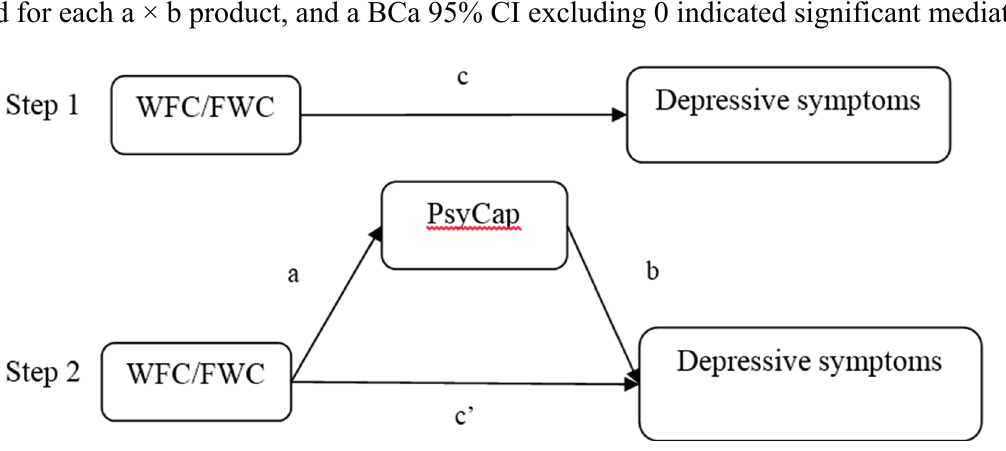
Figure 1. Theoretical model of the mediation of PsyCap on the association between work-family conflict and depressive symptoms. ( c ) the associations of WFC or FWC with depressive symptoms; ( a ) the relationship between work-family conflict and PsyCap; ( b ) the association of PsyCap with depressive symptoms after controlling for the independent variables; ( c’ ) the relationship between work-family conflict and depressive symptoms after adding PsyCap as a mediator.